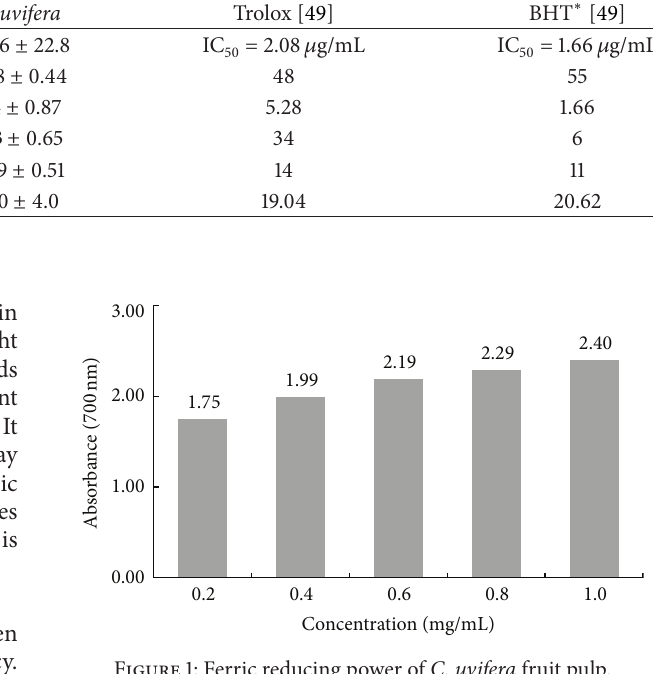
Figure 1: Ferric reducing power of C. uvifera fruit